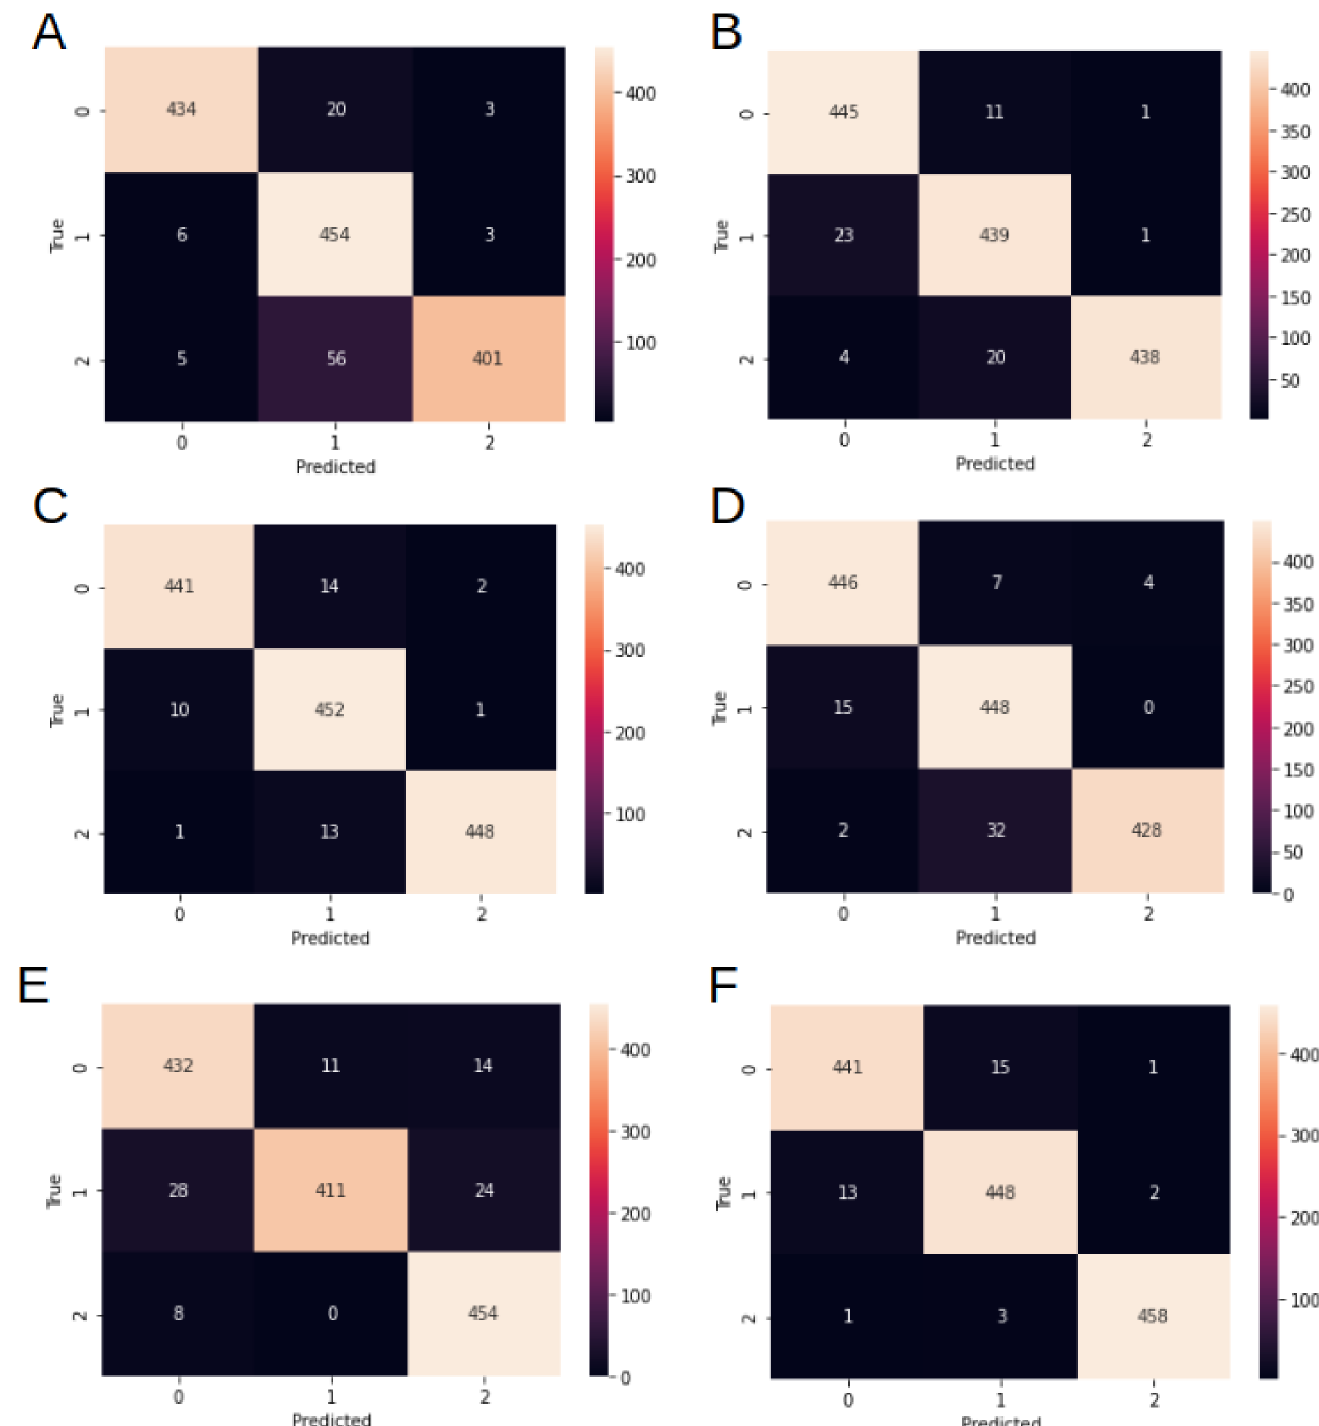
Fig 3. Confusion matrices. Confusion matrices for the experiments varying by the pre-processing method—A: none, B: histogram equalization, C: histogram equalization + Gaussian blur, D: histogram equalization + bilateral filter, E: adaptive mask, F: adaptive mask + histogram equalization + Gausssian blur.